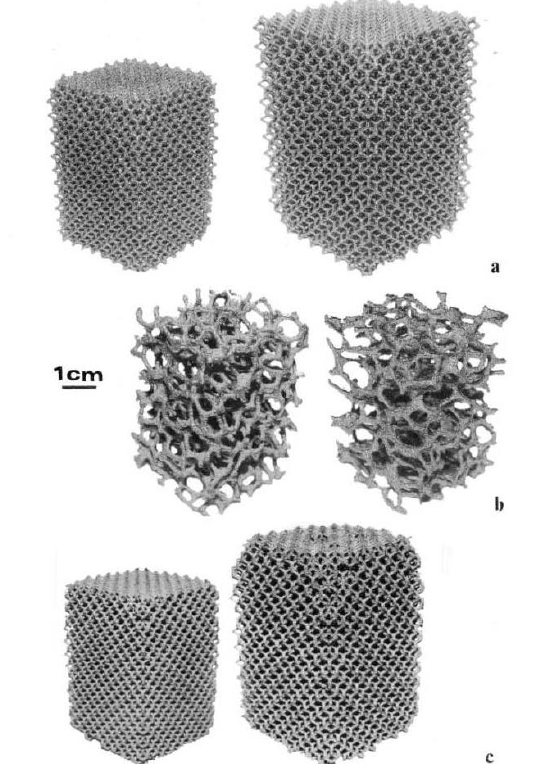
Figure 2. Examples of electron beam melting (EBM) fabricated open-cellular structures. ( a ) Co-Cr-Mo mesh samples having densities of 0.98 g/cm 3 (left) and 1.25 g/cm 3 (right); ( b ) Co-Cr-Mo foam samples having densities of 0.66 g/cm 3 (left) and 0.69 g/cm 3 (right); ( c ) Ni-base alloy 625 mesh samples having densities of 1.37 g/cm 3 (left) and 1.80 g/cm 3